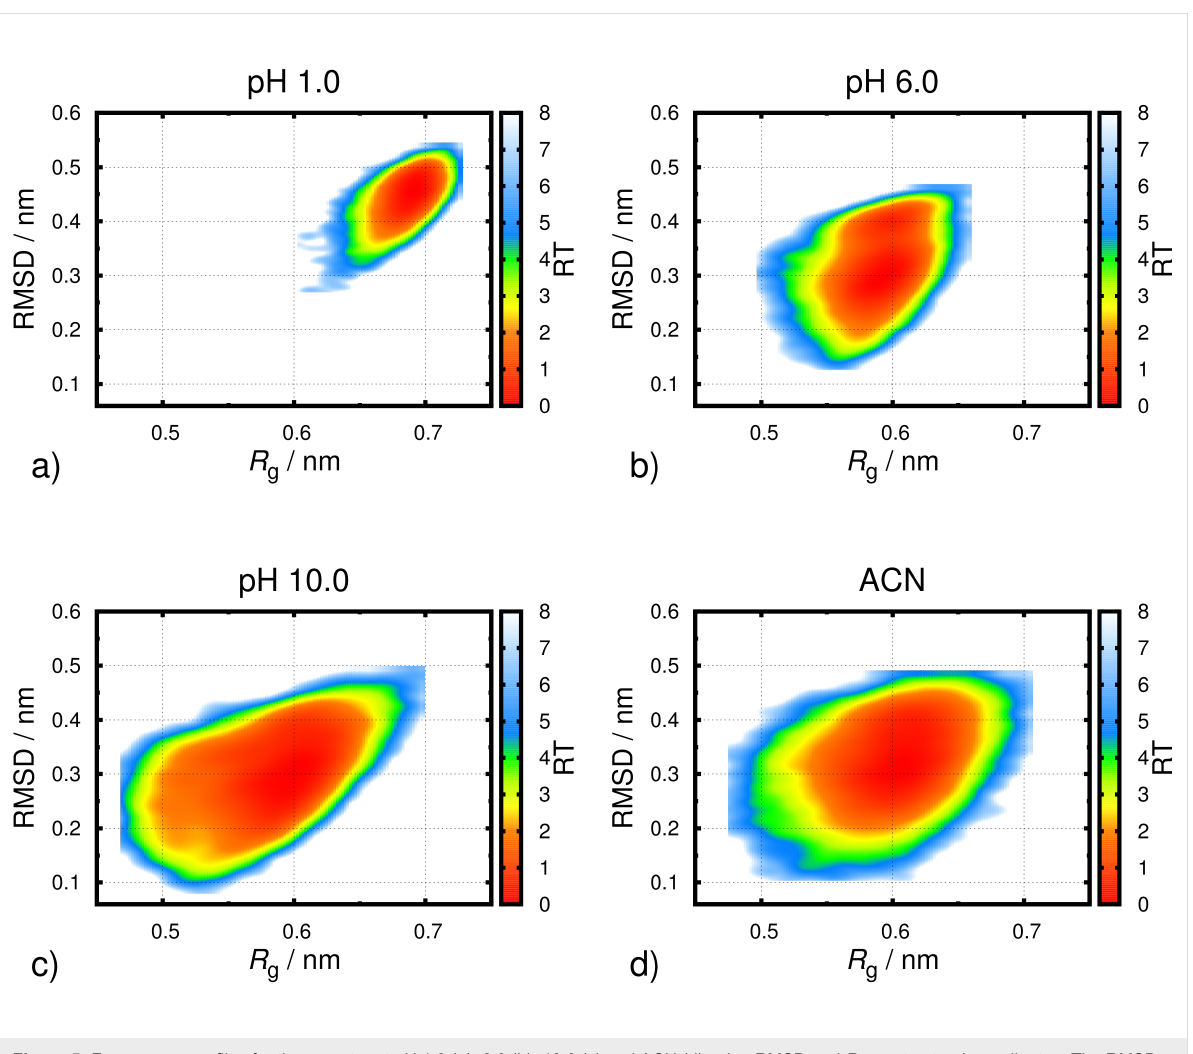
Figure 5: Free energy profiles for the receptor at pH 1.0 (a), 6.0 (b), 10.0 (c) and ACN (d) using RMSD and R g as structural coordinates. The RMSD was calculated using the NMR derived structure as